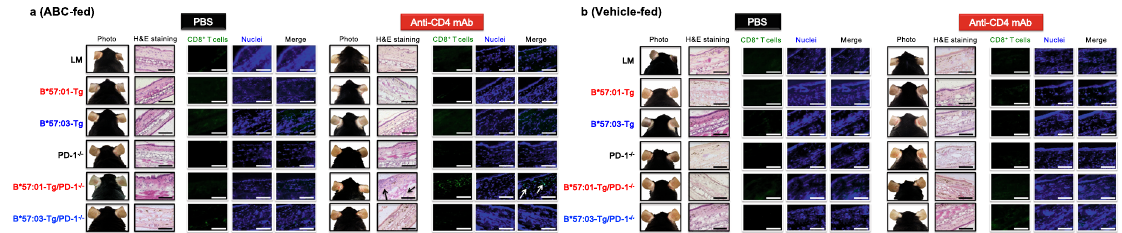
Fig. 4 Abacavir (ABC)-induced immunotoxicity in CD4 + T cell-depleted B*57:01-Tg/PD-1 − / − transgenic mice. a and b Representative images of photos of the ears or ear section either stained with hematoxylin and eosin (H&E) or immuno-stained with CD8, and nuclear stained. Each group was orally administrated ( a ) 1% (w/w) abacavir (ABC) or ( b ) normal diet (vehicle) for 1 week. Each scale bar represents 100 μ m. Arrows show the lymphocytic in fi ltration (H&E staining) and CD8 + T cell in fi ltration (CD8 immunohistochemistry). Data are representative of three independent experiments.